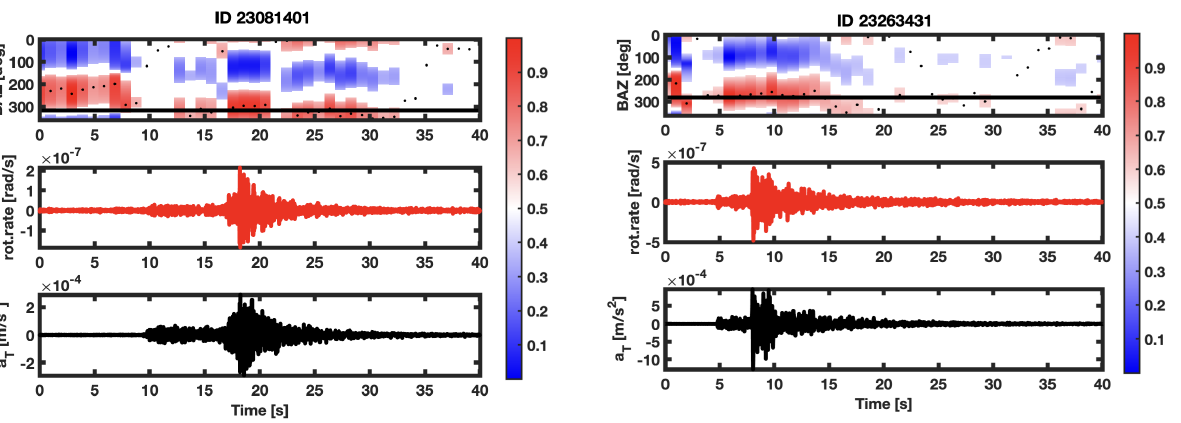
Figure 2. Example of BAZanalysis for two selected